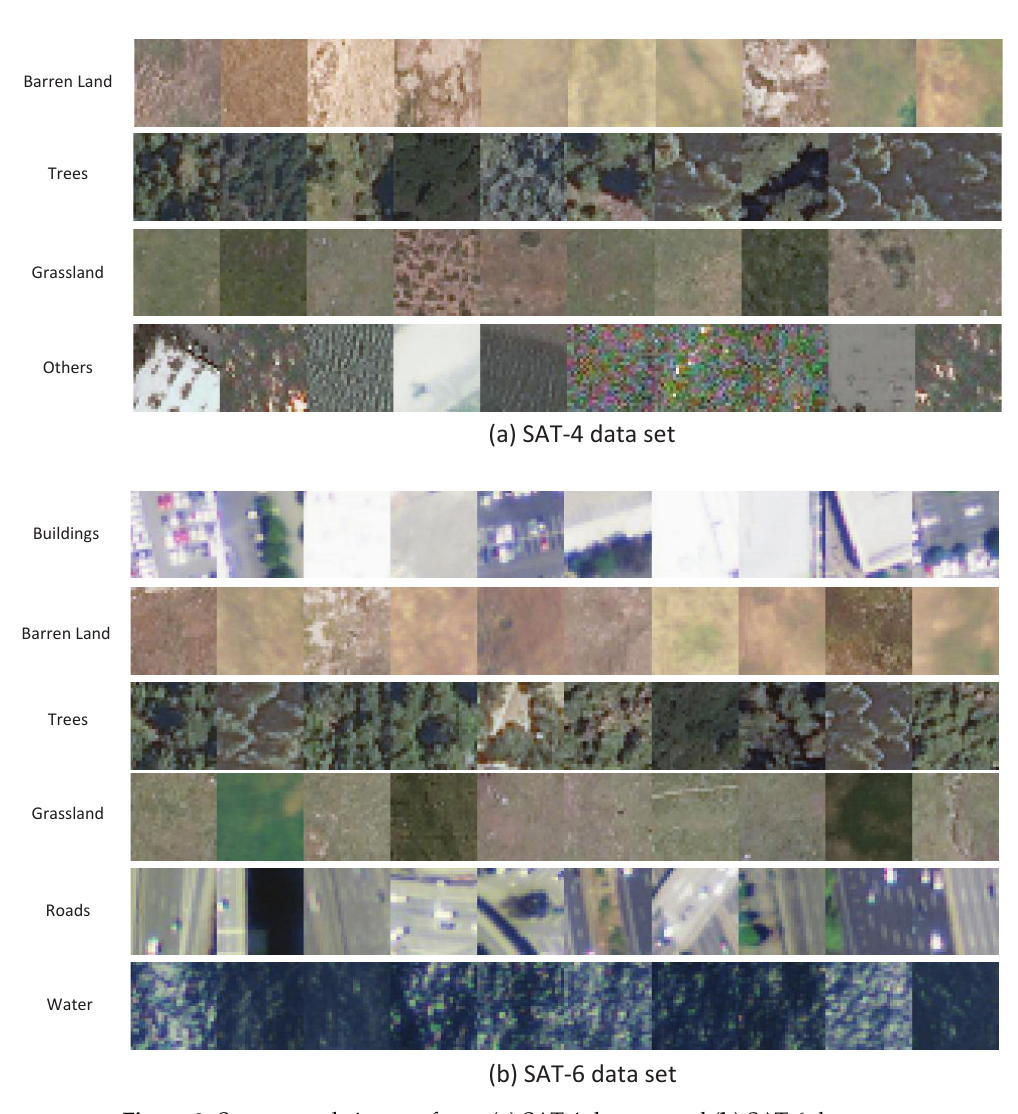
Figure 2. Some sample images from: ( a ) SAT-4 dataset; and ( b ) SAT-6